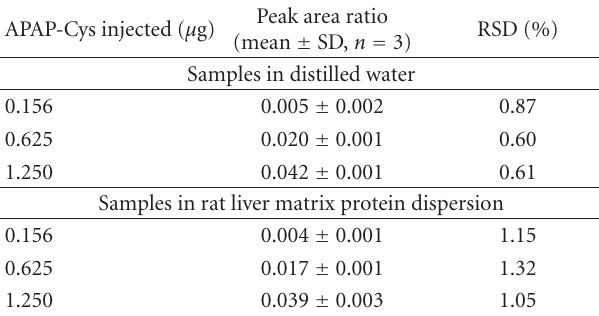
Table 3: Results of the interday variability study on the proposed HPLC method based on three di ff erent concentrations of APAP- Cys added to distilled water and to blank rat liver matrix protein dispersion a . APAP-Cys injected ( µ g)